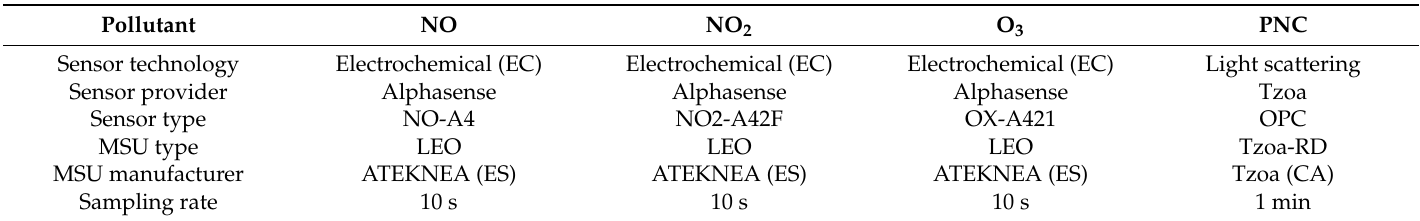
Table 3. Specifications of the personal MSUs for pollutant